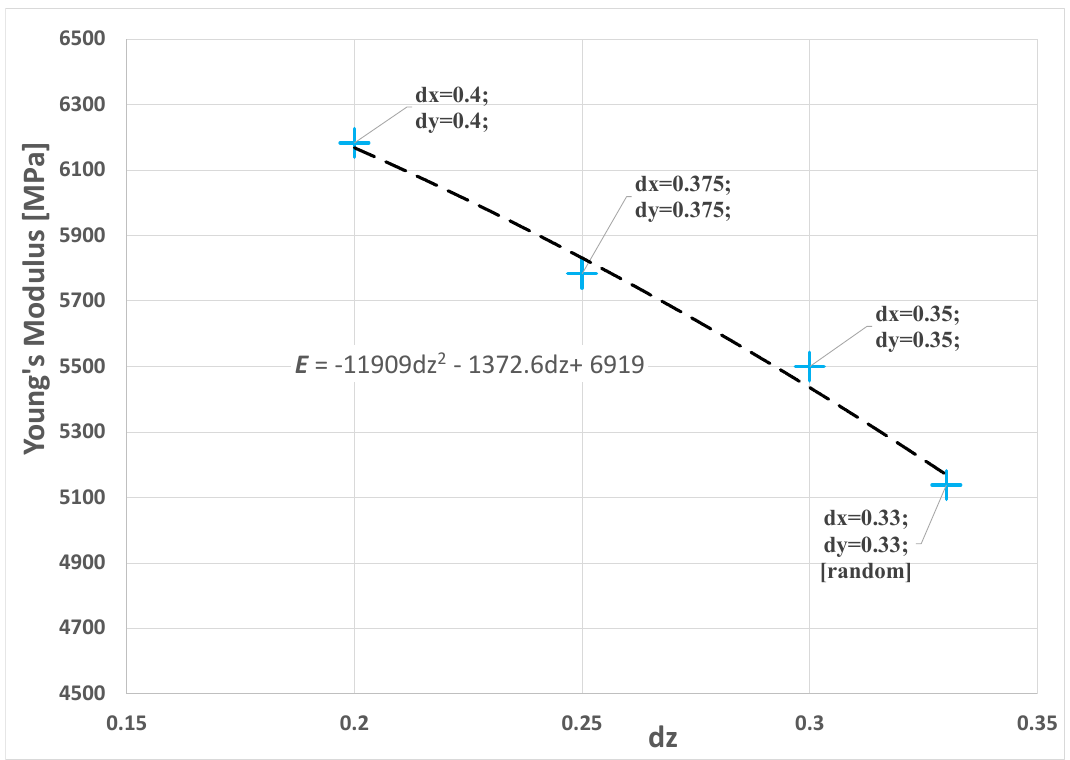
Figure 11. Graph of the resulting Young’s modulus of the composite in the x - y plane as the distribution of the orientation of the fibers varied.